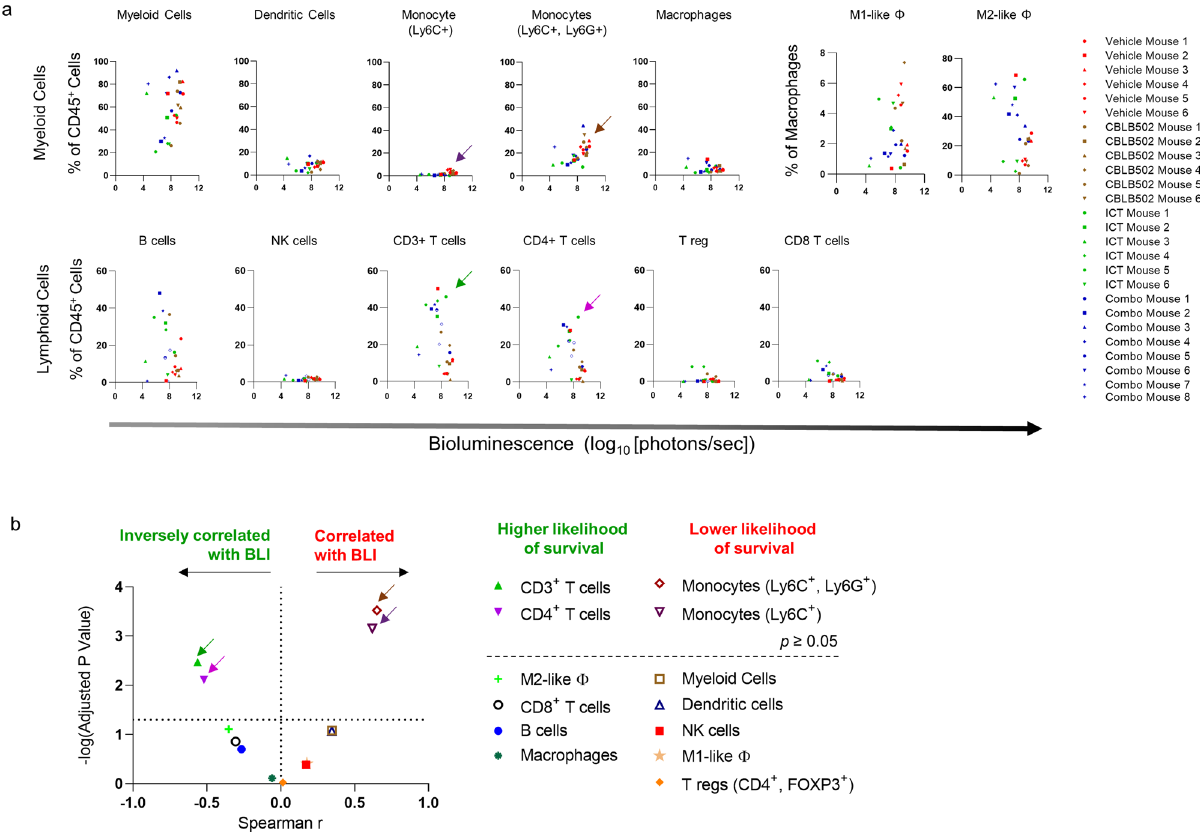
Fig. 6 Tumor immune in fi ltrate pro fi le of vehicle and treated mice, three weeks post orthotopic 4T1 FUGW-FL tumor implantation. a Myeloid (top panel) and lymphoid (bottom panel) tumor immune in fi ltrate pro fi le of vehicle and treated mice, assigned a Log BLI measurement taken 3 weeks post 4T1 FUGW-FL tumor implantation and prior to tumor extraction. b Volcano plot highlighting the correlation between immune in fi ltrate and Log BLI. Vertical line demarks negative and positive Spearman r correlation values. Line of identity indicates p = 0.05. Green, light purple, brown, and dark purple arrows highlight CD3 + T cells, CD4 + T cells, monocytes (Ly6C + , Ly6G + ), and monocytes (Ly6C + ), respectively, in panels A and